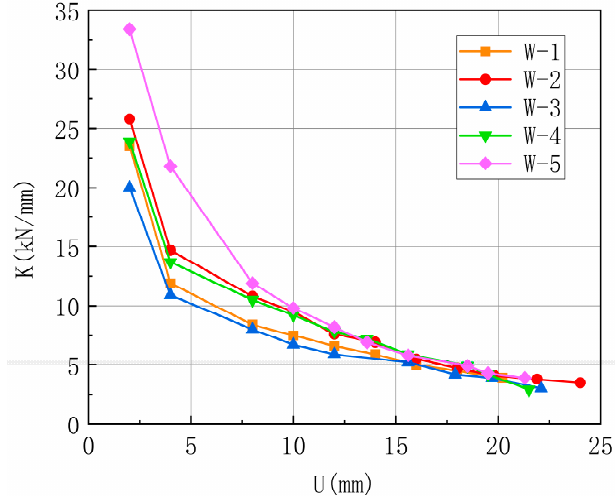
Figure 11. Comparison chart of stiffness degradation.